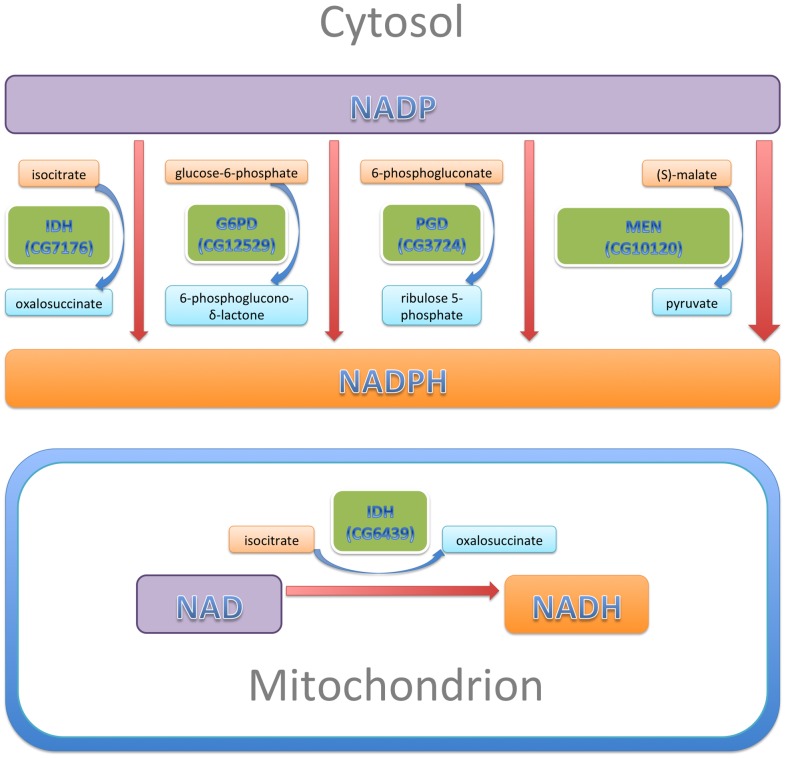
NADP/H metabolism: The major enzymatic sources of cytosolic NADPH are indicated, along with their reactants.The sizes of the enzyme boxes are drawn in approximate proportion to their contribution to the cytosolic NADPH pool. The NAD-dependent mitochondrial IDH, which was tested in this study, is also indicated.